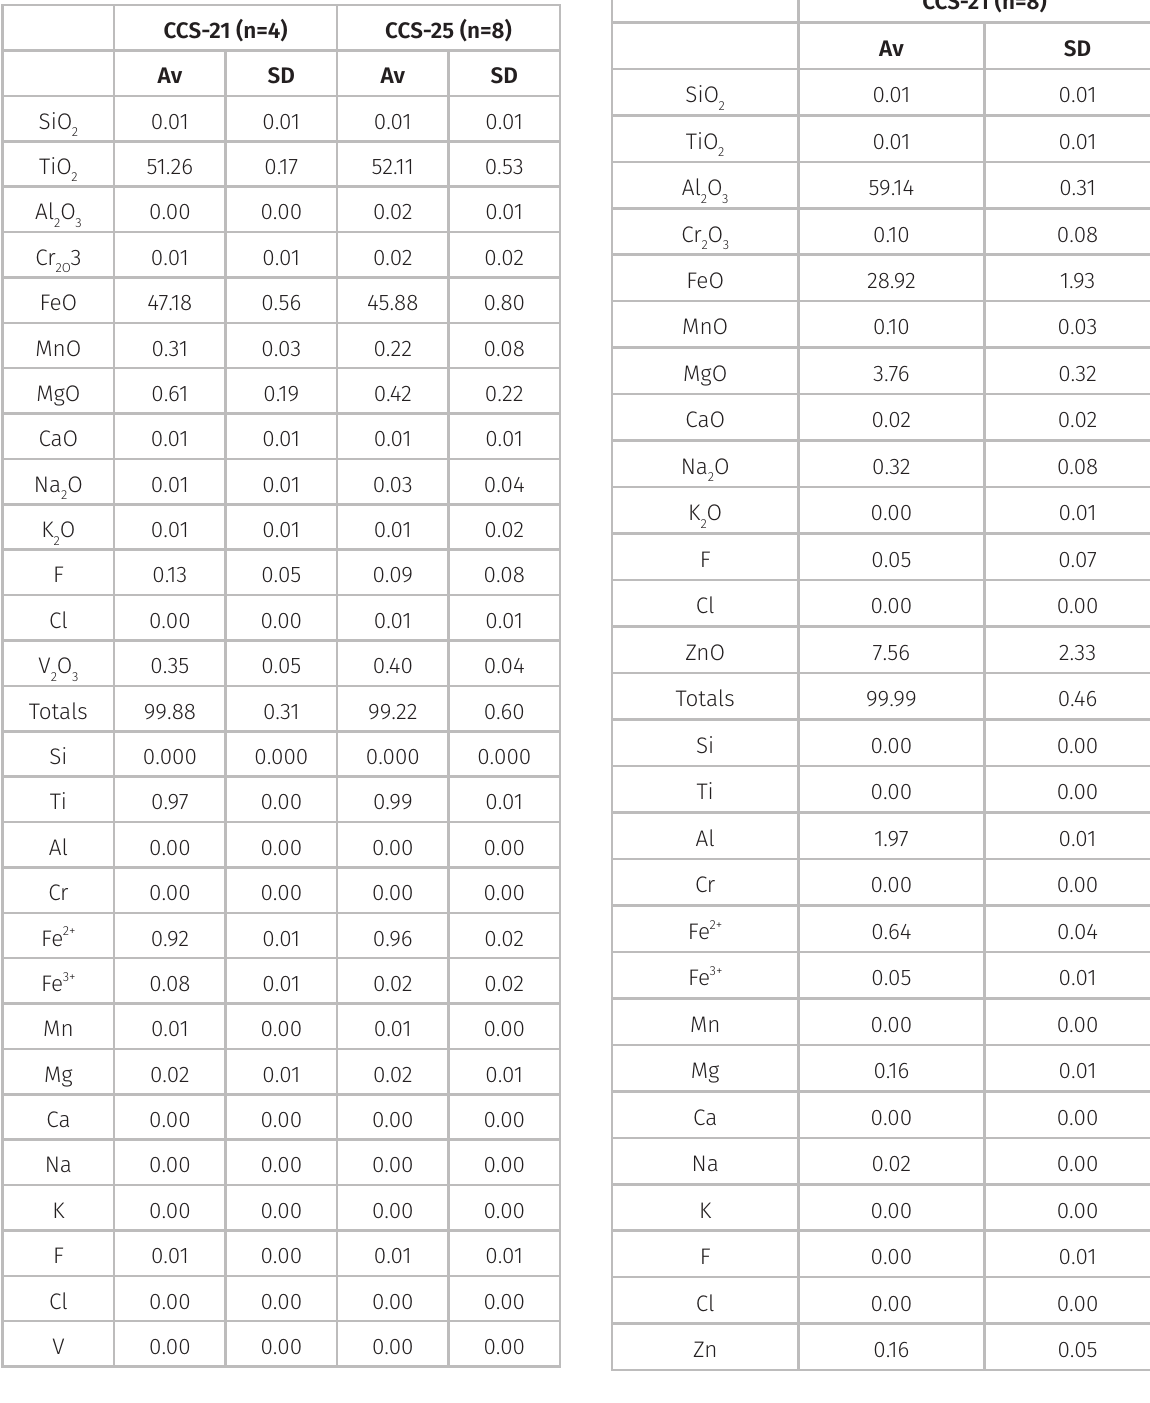
Table IV. Average (Av) and standard deviation (SD) of the mineral chemistry of ilmenite. Calculations based on 3 oxygens, following the methodology of Droop (1987).